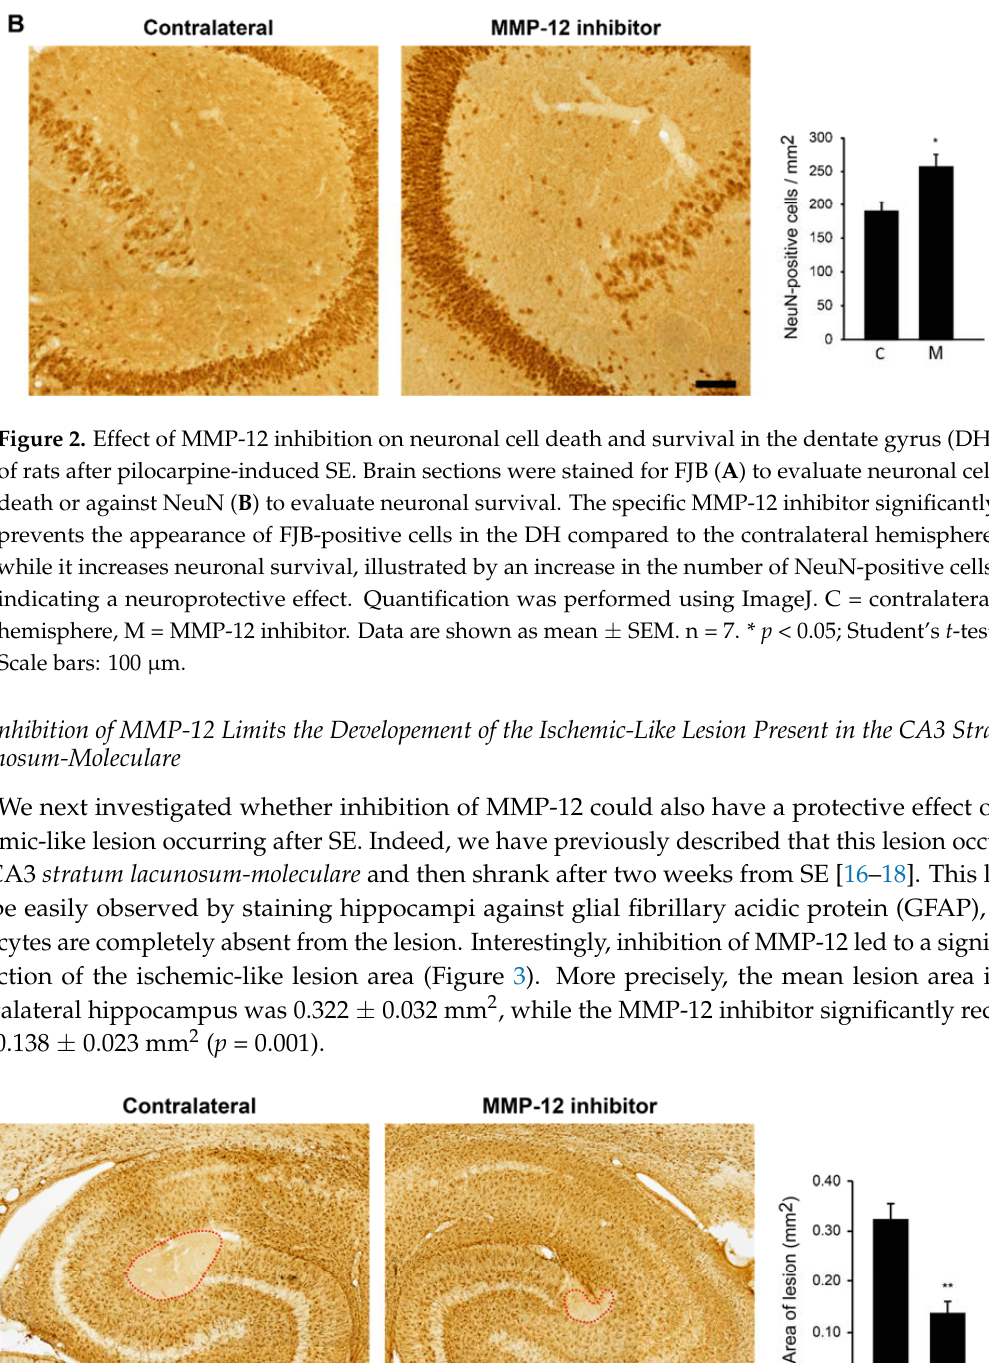
Figure 3. Effect of MMP ‐ 12 inhibition on the ischemic ‐ like lesion in the CA3 stratum lacunosum ‐ moleculare of rats after pilocarpine ‐ induce SE. Brain sections were stained against GFAP, a marker of astrocytes, which are absent in the lesion occurring in the CA3 stratum lacunosum ‐ moleculare . The selective MMP ‐ 12 inhibitor significantly prevented the enlargement of the lesion area. Quantification of the area (red ‐ dotted circle) was performed using the image analysis software KS300. C = contralateral hemisphere, M = MMP ‐ 12 inhibitor. Data are shown as mean ± SEM. n = 7. ** p < 0.01; Student’s t ‐ test. Scale bar: 500 μ m.